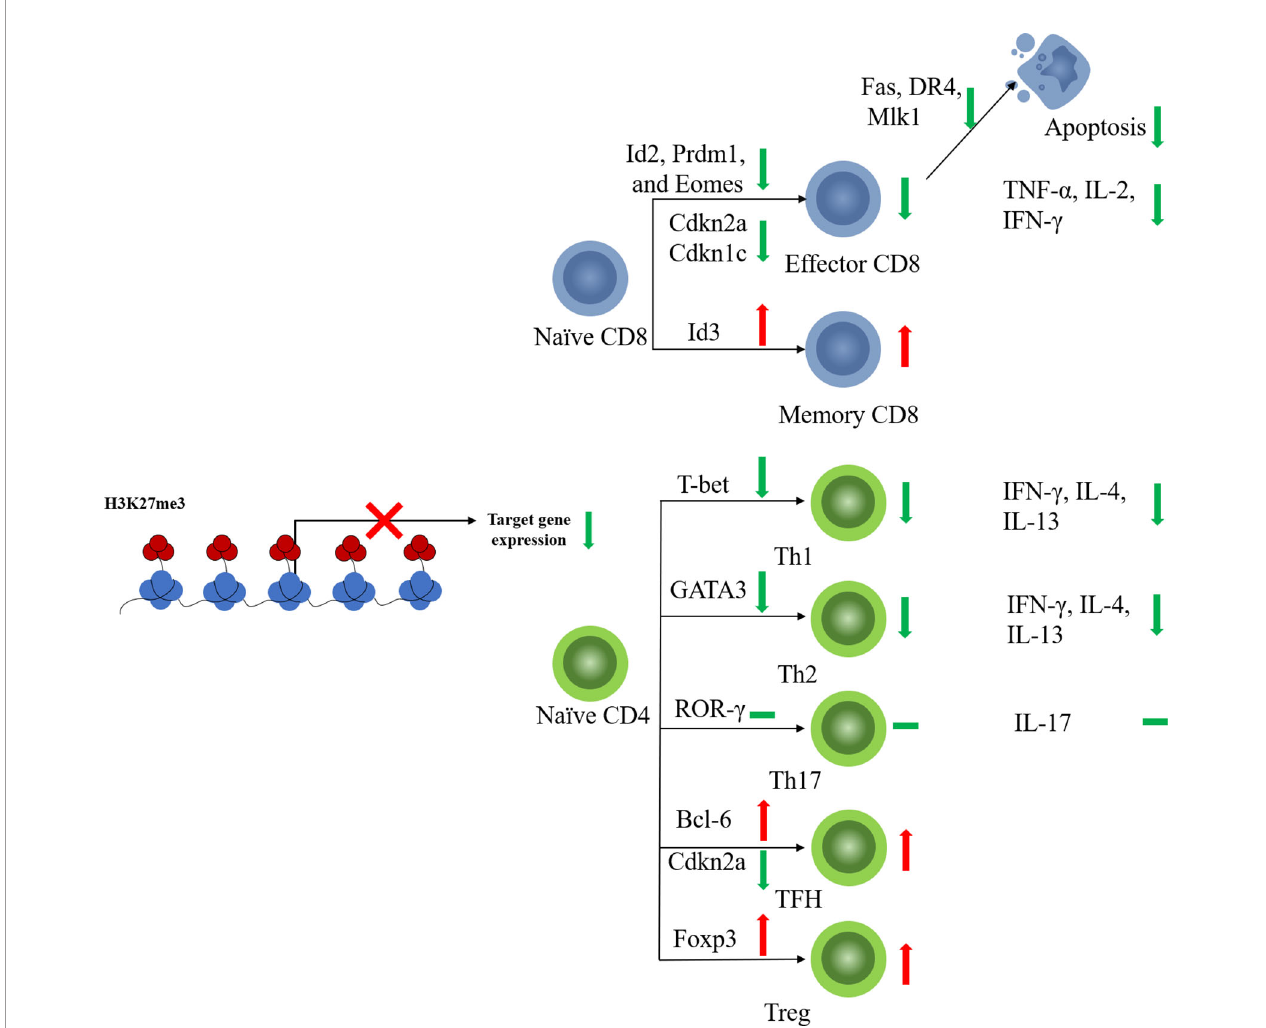
FIGURE 2 | EZH2 function on T cell fates. EZH2 affects differentiation of CD4+ or CD8+ naïve T cells toward effector subtypes by regulating the expression of key transcription factors. EZH2 can also limit the apoptosis of mature effector T